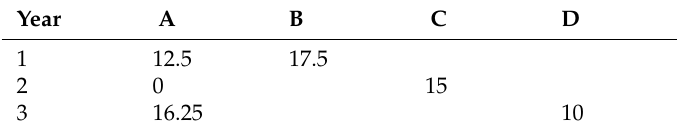
Table 2. Investment strategy (only profit is considered).